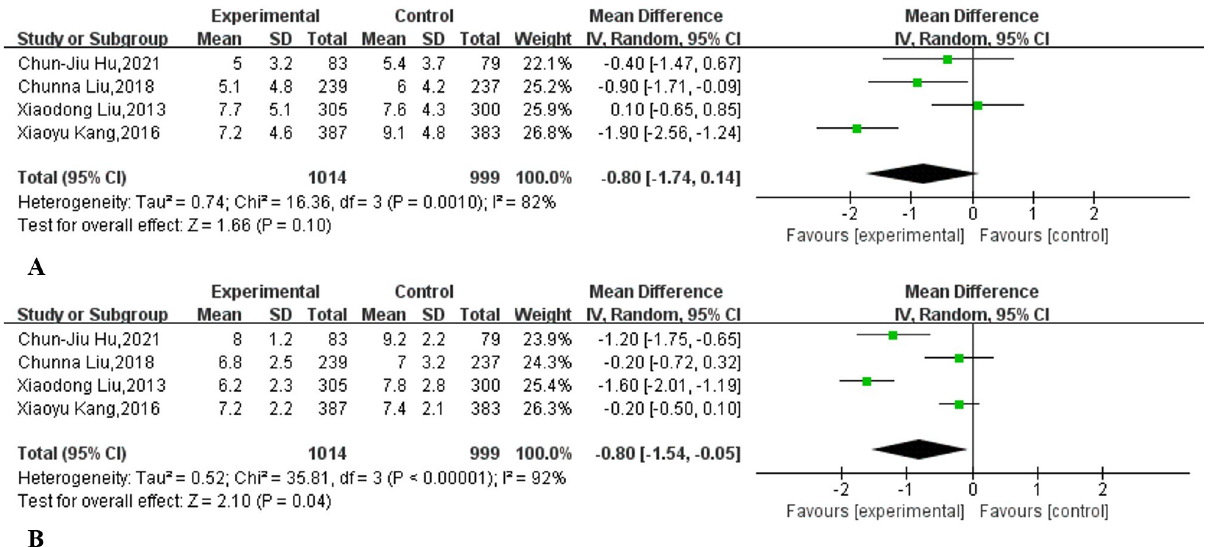
Fig 7. Forest plot comparing (A) cecal intubation time (CIT) and (B) withdrawal time (WT) supplementary education combined with traditional education and traditional education alone.